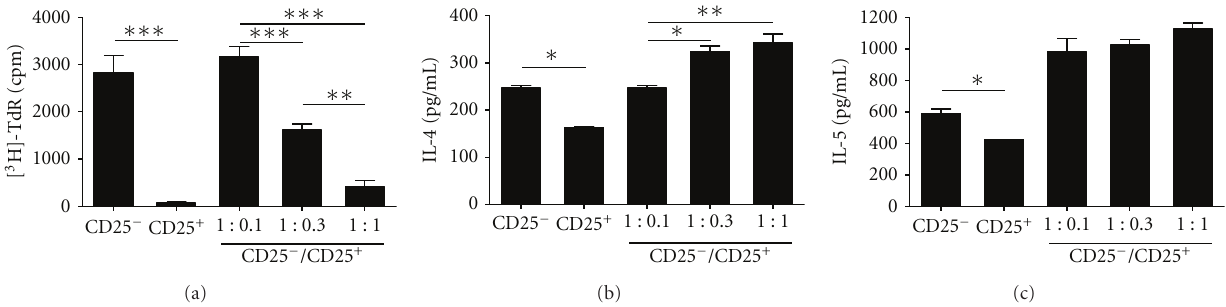
Figure 6: Lung CD4 + CD25 + T cells from allergic mice suppress T-cell proliferation but not Th2 cytokine production. (a) Proliferation of MACS-purified lung CD4 + CD25 − or CD4 + CD25 + cells from BALB/c allergic mice alone or cocultured at di ff erent CD25 − /CD25 + ratios determined by 3 H-thymidine ( 3 H-TdR) incorporation after anti-CD3 stimulation. ELISA assays for (b) IL-4 and (c) IL-5 in the culture supernatants showed in (a). Values represent the means ± SEM of triplicate wells. The results are representative of two experiments. Significant di ff erences ∗ P < 0 . 05, ∗∗ P < 0 . 01, and ∗∗∗ P < 0 . 001 are shown.